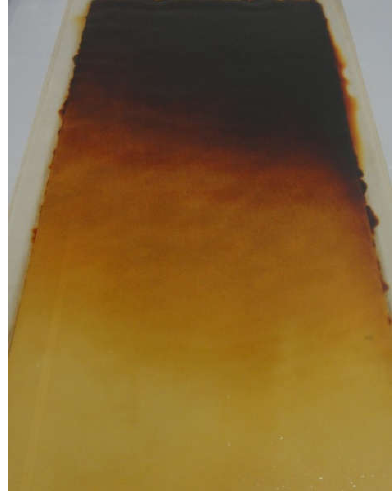
Figure 1. Neosepta® AMX used in electrodialysis (ED) desalination of leachate for 8 years with Figure 1. Neosepta ® AMX used in electrodialysis (ED) desalination of leachate for 8 years with appropriate cleaning-in-place (CIP) treatments. appropriate cleaning-in-place (CIP)